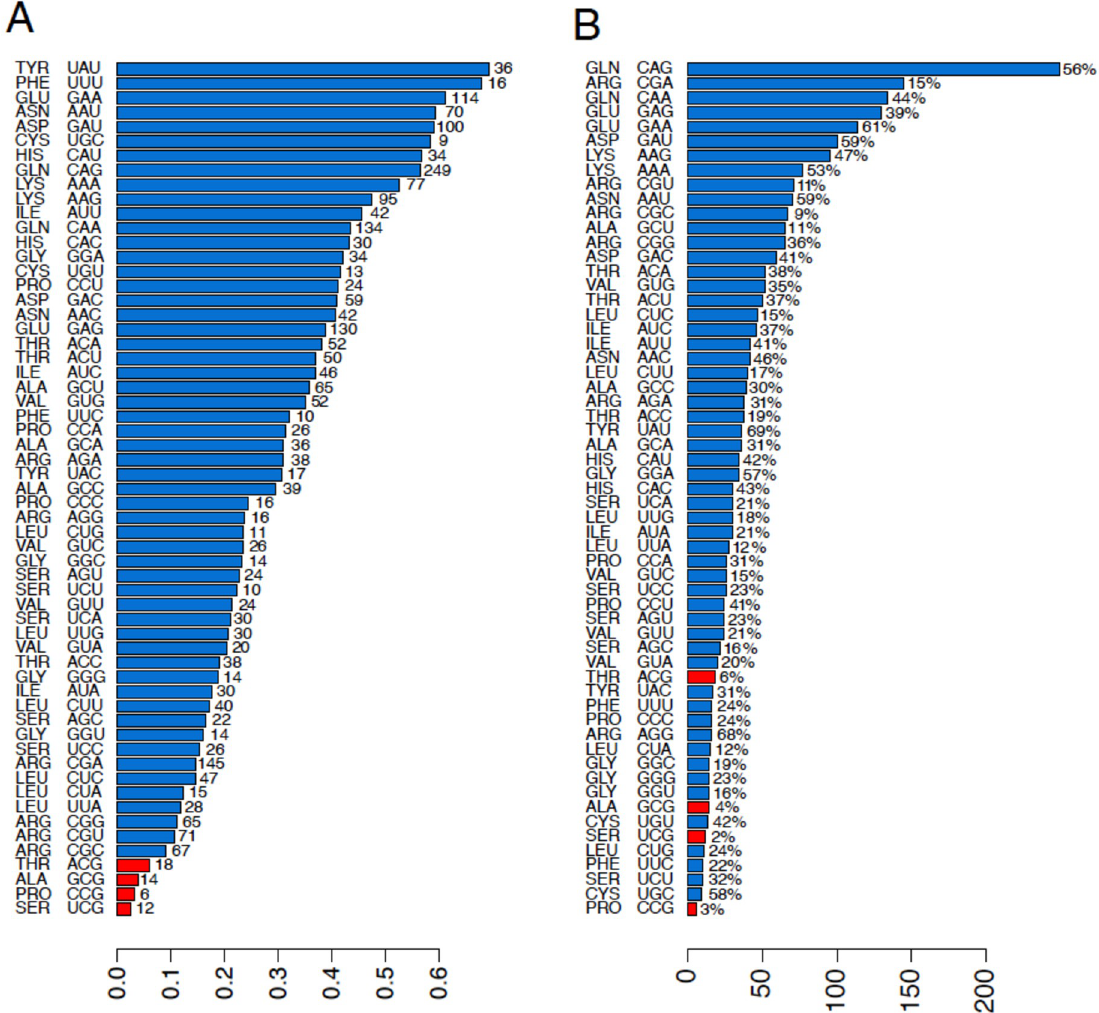
Fig 6. Human DMD gene codon usage and mutations “mapping-on-codon” approach. Panel A Human DMD codon usage values and mutation percentages. The bars represent the CU values in DMD gene in HSA . On the x-axis, codon types and the relative amino acid are listed, on the y-axis CU values are reported. Red bars represent the 4 DMD rarely used codons UCG, CCG, ACG and GCG, according to our cut-off, which is based on codon redundancy of 2, 3, 4 and 6 triplets (see Methods). On the top of bars (right side), the numbers of missense and nonsense mutations occurred at the relative DMD codons are reported. All codons are still used by the DMD human gene, and the frequency of mutation occurrence is not related to the codon usage values. Examples are UAU, which is the most used codon, but with only 36 “mapped” mutations, or CGA (Arg) which is rarely used but has 114 “mapped” mutations. Panel B. Mapping of human DMD missense and nonsense mutations on codon types. On the x-axis, there are codons and the relative amino acid, on the y-axis, there is the number of mutations which have occurred and “mapped”. Red bars represent the 4 rarely used codons in the DMD human gene according to our cut-off. On the top of the bars there is the percentage of CU values. The number of occurring mutations and the CU values are not strictly related. Examples are CAG, which is the “more frequently” mutated codon (56%), with high CU values, and UGC (Cys), rarely site of mutations, but with very high CU